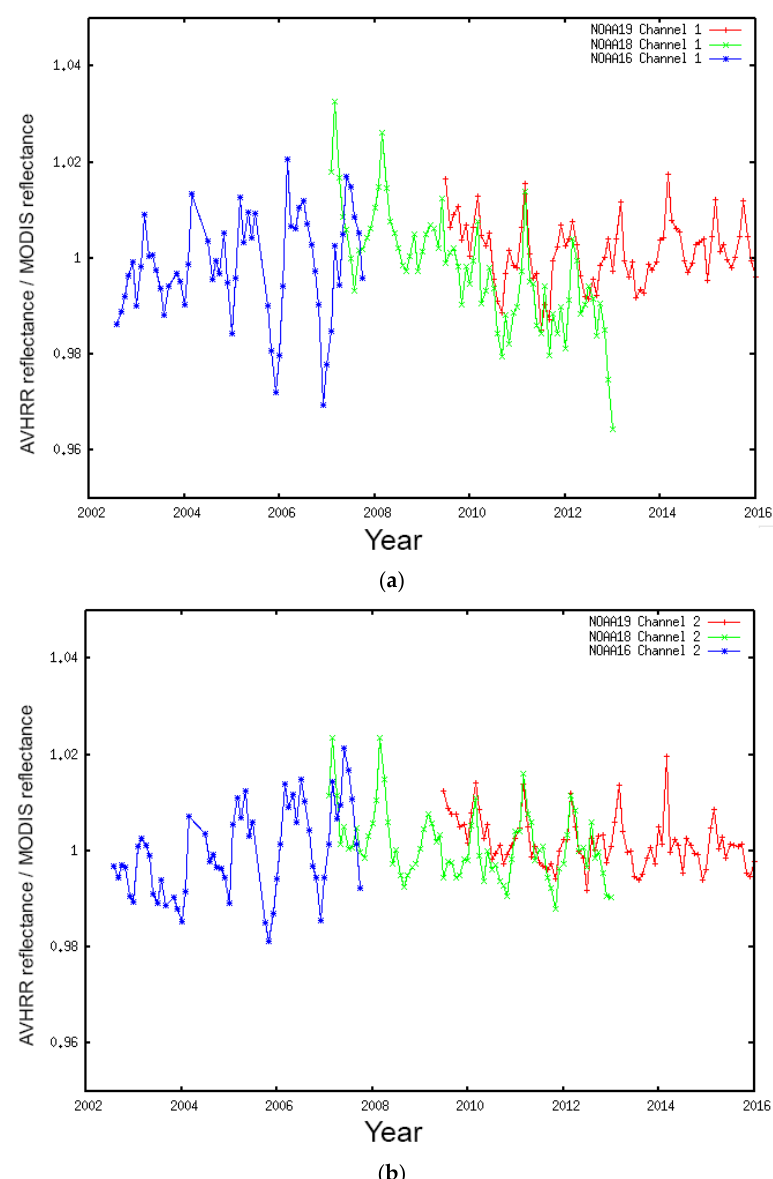
Figure 7. Cross-comparison between AVHRR N16, N18, and N19 and MODIS Terra ratios for the BELMANIP2 sites for the red band ( a ) and the near infrared band ( b ).